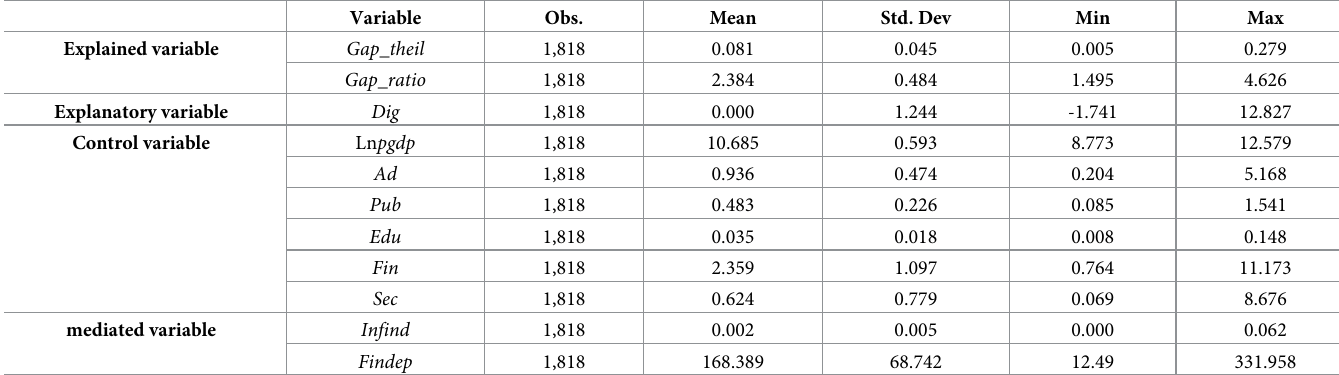
Table 1. Descriptive